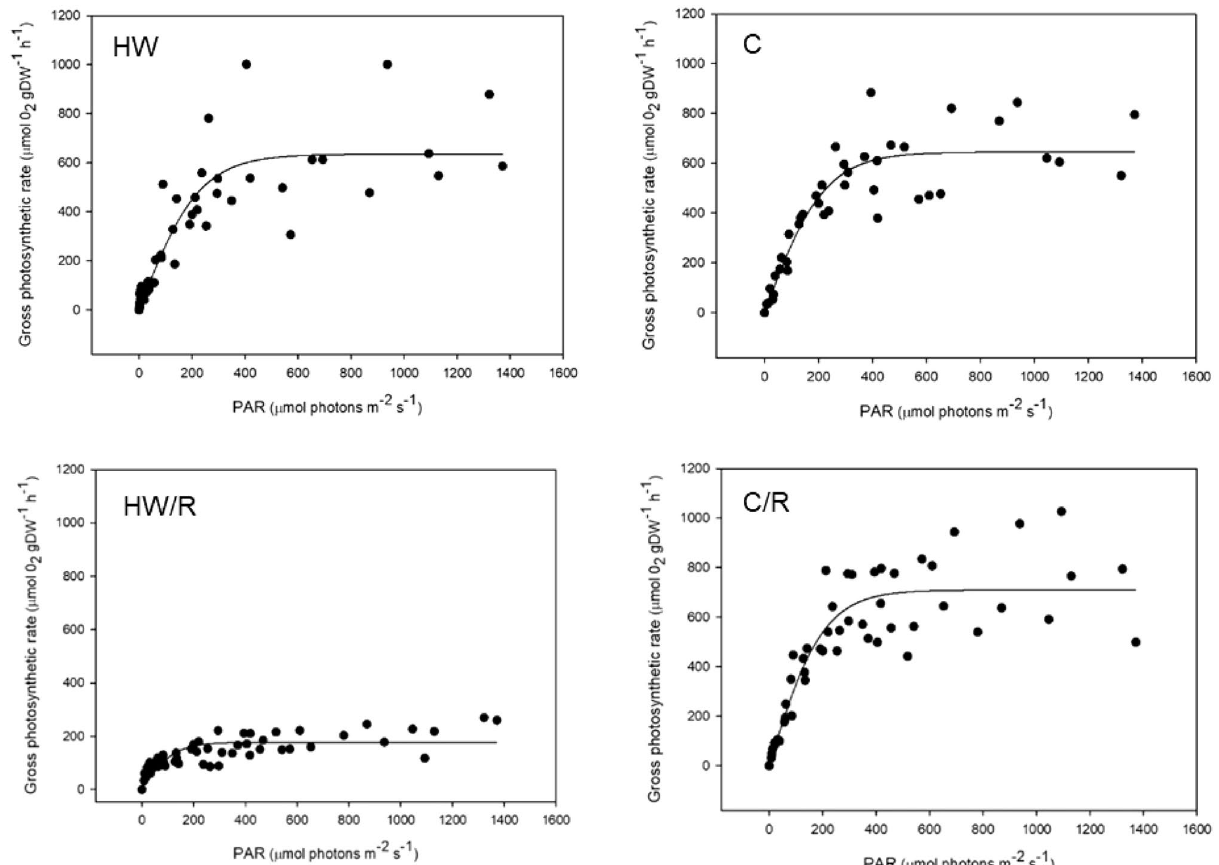
Figure 1. P-I curves of C. nodosa ’s leaves. Leaves were sampled during the heatwave peak (heatwave, HW, and control, C) and after a 7-day recovery (HW/R and C/R). Data were fitted with the Jassby & Platt (1976) model equation.